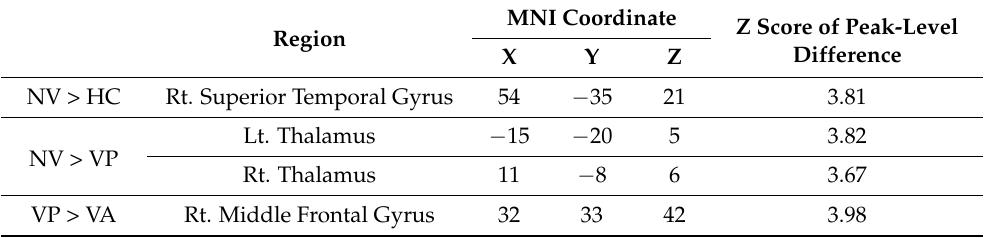
Figure 2. The VBM analysis of GM volume between the VP, VA, and NV groups. The yellow-white color indicates the significantly different GM volumes between VP and NV in the bilateral thalamus ( A – C ), and between VA and VP in the right middle frontal gyrus ( D – F ). The images are shown in axial ( A , D ), coronal ( B , E ), and sagittal views ( C , F ). Table 2. The Montreal Neurological Institute (MNI) coordinates of regions with significant difference of GM volume between two groups.